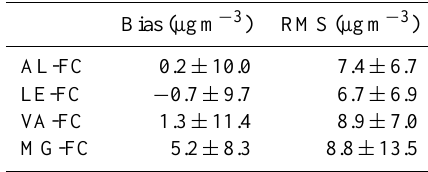
Table 1. Bias and RMS differences between dust load esti- mates (µgm − 3 ) performed at the regional background station of Fontechiari (FC) with respect to equivalent estimates performed at the two city stations of VA and MG, and at two other regional back- ground stations (Allumiere, AL, and Leonessa,